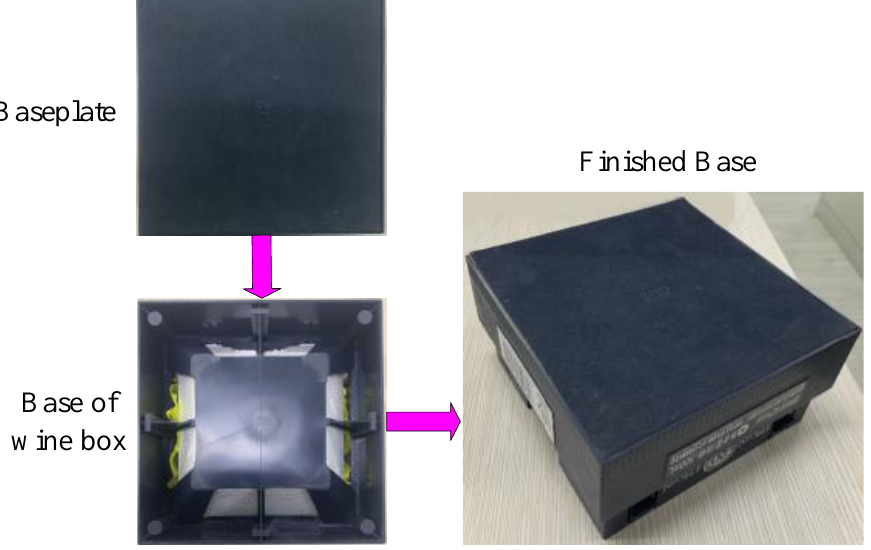
Figure 6. Assembly diagram of a wine box base.